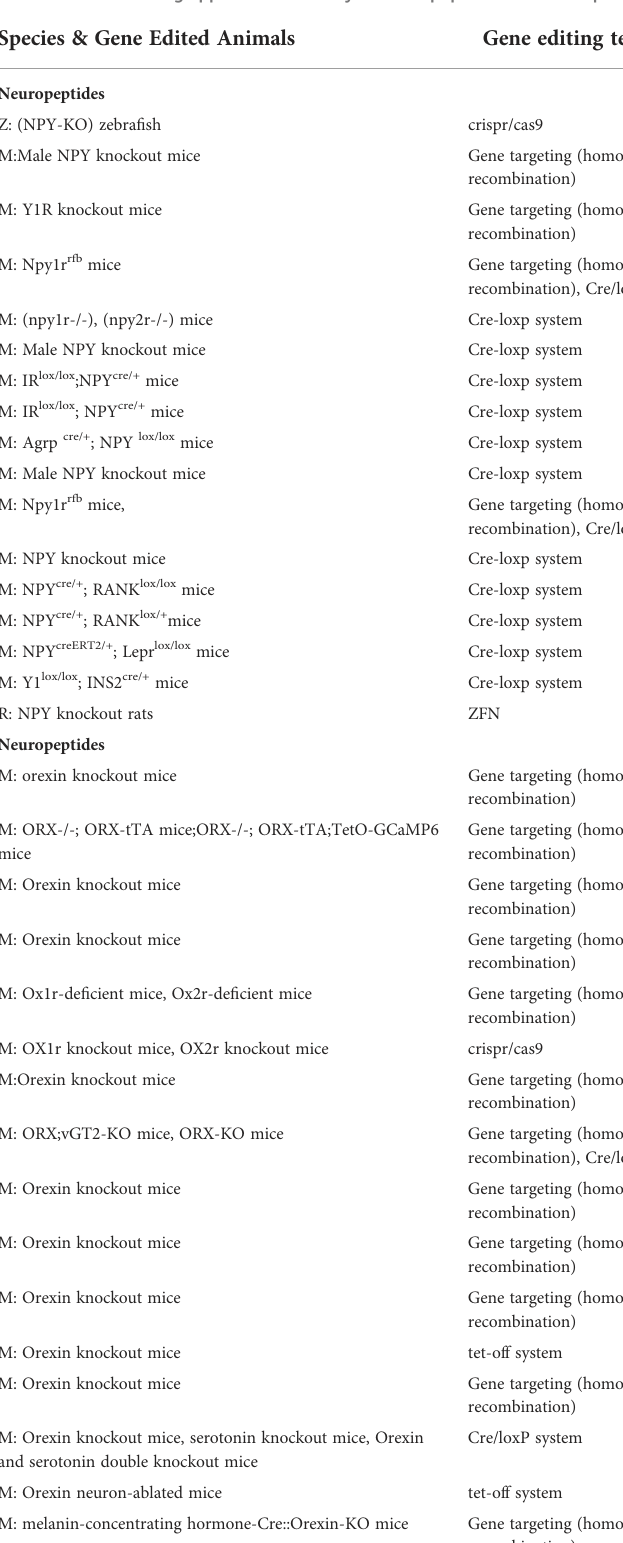
TABLE 2 Gene editing applied to the study of neuropeptide and its receptor